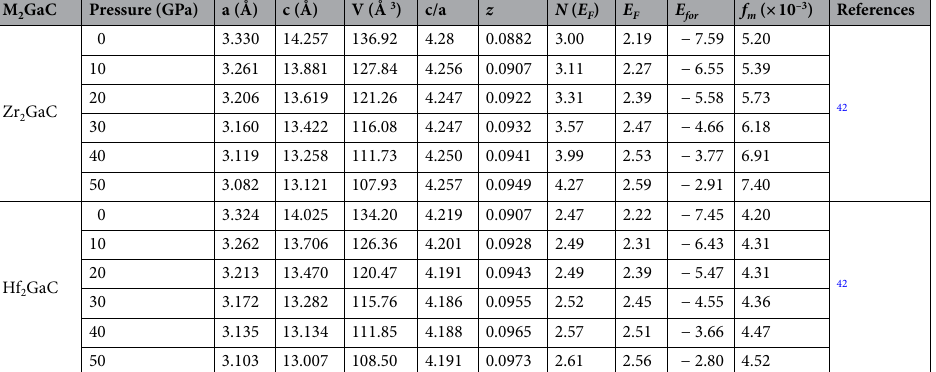
Table 1. Calculated lattice parameters (a) and (c) in Å, unit cell volume (A 3 ), c/a, internal parameter (z), no. of DOS at E F (states/eV/unit cell), formation energy E for (eV/atom), metallicity ( f m ), and Fermi energy E F (eV) for M 2 GaC MAX phase (M = Zr, Hf) obtained by GGA-PBE at 0–50 GPa